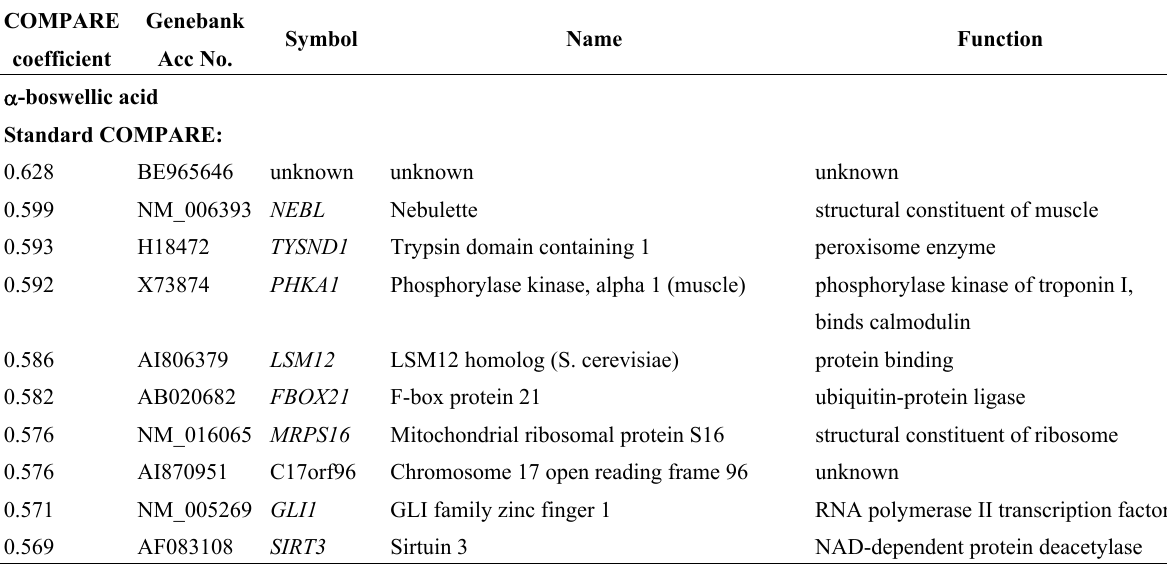
Table 2. Genes identified by standard or reverse COMPARE analyses, whose